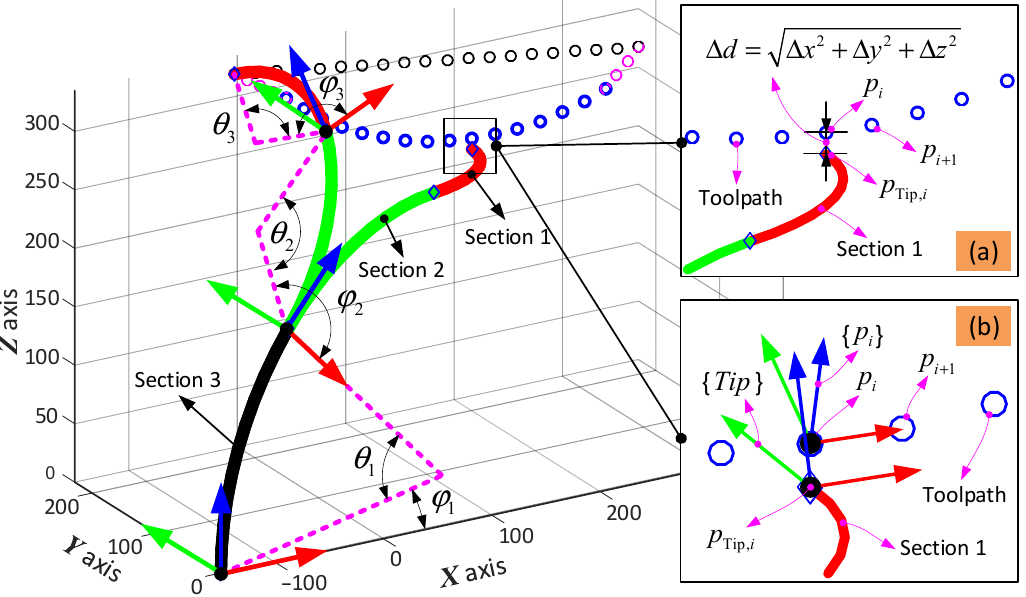
Figure 6. Optimization-based path planning for the 6-DoF continuum arm: ( a ) and ( b ) are the error definitions of the position and orientation.